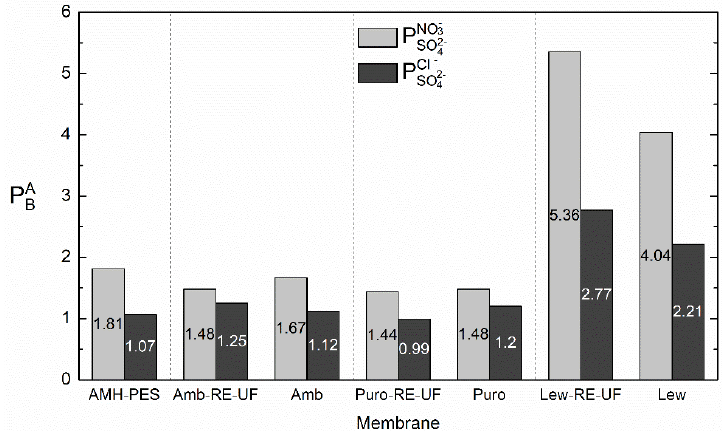
NO − − ) withandwithout 3 and P Cl SO 2 − SO 2 − 𝑁𝑂 3− and 𝑃 𝐶𝑙 − ) with and 4 4 𝑆𝑂 4 2− 𝑆𝑂 4 2−